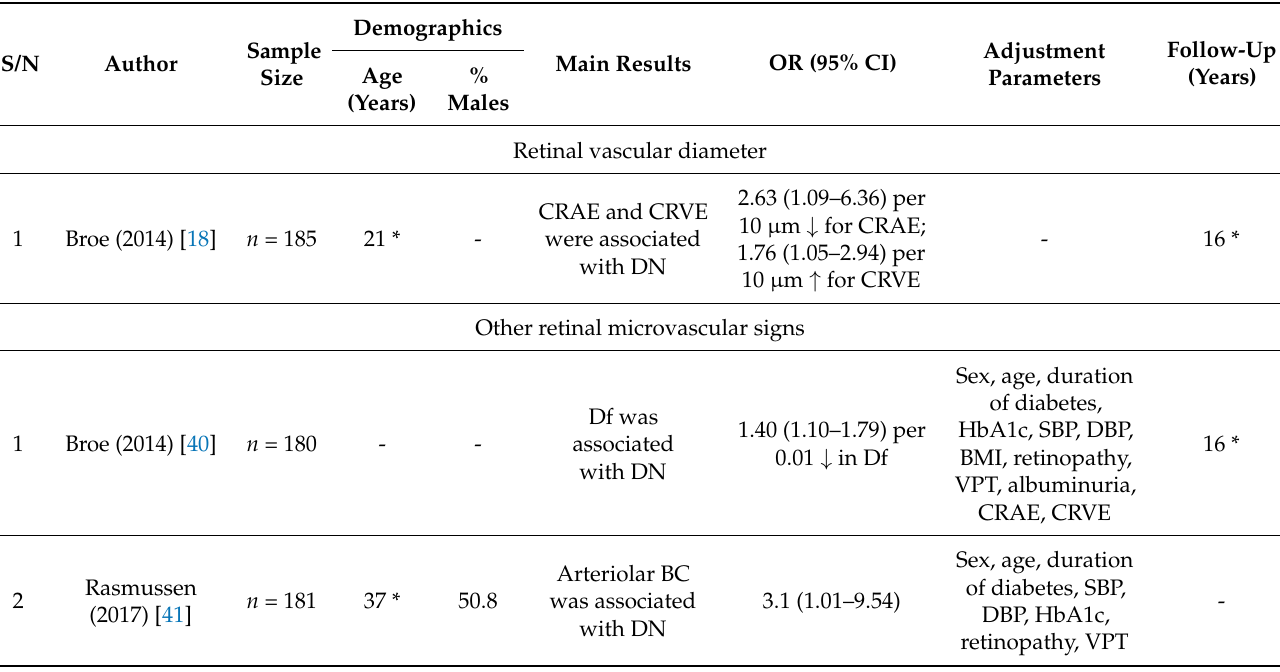
Table 9. Retinal microvascular signs and